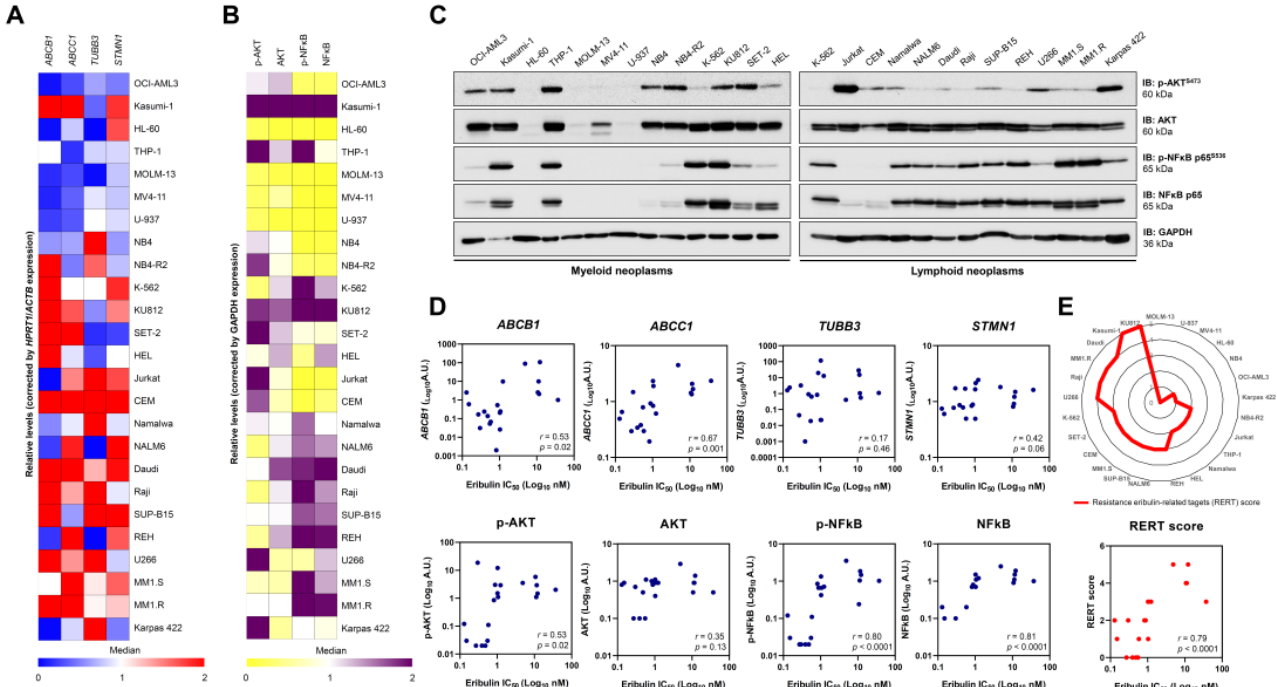
Figure 7. Resistance to eribulin is associated with the high expression/activation of MDR1, NFκB, and AKT in blood cancer cells. The heatmaps illustrate the expression of genes ( A ) or proteins ( B ) associated with resistance to eribulin in a panel of hematologic neoplasm cell lines. Gene data are represented as relative expression corrected by HPRT1 / ACTB expression. Downregulated and upregulated genes are given by blue and red, respectively. Protein expression data are represented as relative levels corrected by the expression of GAPDH. Downregulated and upregulated proteins are indicated by yellow and purple, respectively. ( C ) Representative Western blot analysis for phospho(p)-AKT S473 , AKT, (p)- NFκB p65 S536 , and NFκB p65 in total cell extracts from myeloid and lym- phoid neoplasms cell lines. ( D ) Correlation graphs between expression of ABCB1 , ABCC1 , TUBB3 , STMN1 , p-AKT, AKT, p- NFκB, or NFκB and IC 50 values for eribulin in blood cancer cells. ( E ) Using